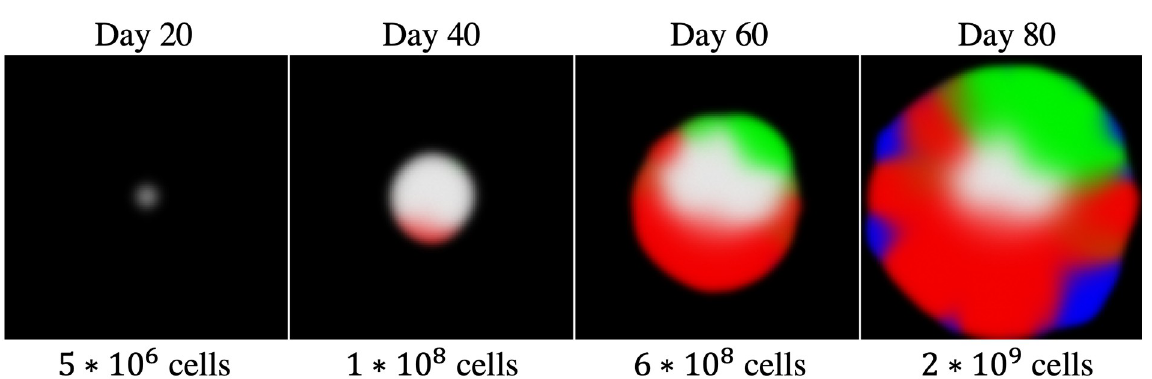
Fig 4. An example PopulationGrid model of tumor growth and mutation in 2D (located in Examples/PopulationTumor). At the start 1000 cells are placed in the center of the domain. Cells turn over and migrate over time. Two fitness-increasing mutations are possible, and can occur with probability 2 × 10 − 6 per cell division. The colors white, red, green, and blue indicate density of cells with no mutations, one mutation, the other mutation, and both mutations respectively. Each lattice position in the domain has a carrying capacity of 100,000 cells. If we assume that cells are growing in cubic volumes, then each position represents an overall area of 1 mm 3 for a total domain size of 150 × 150 × 1 mm. Displayed using the GridWindow object.